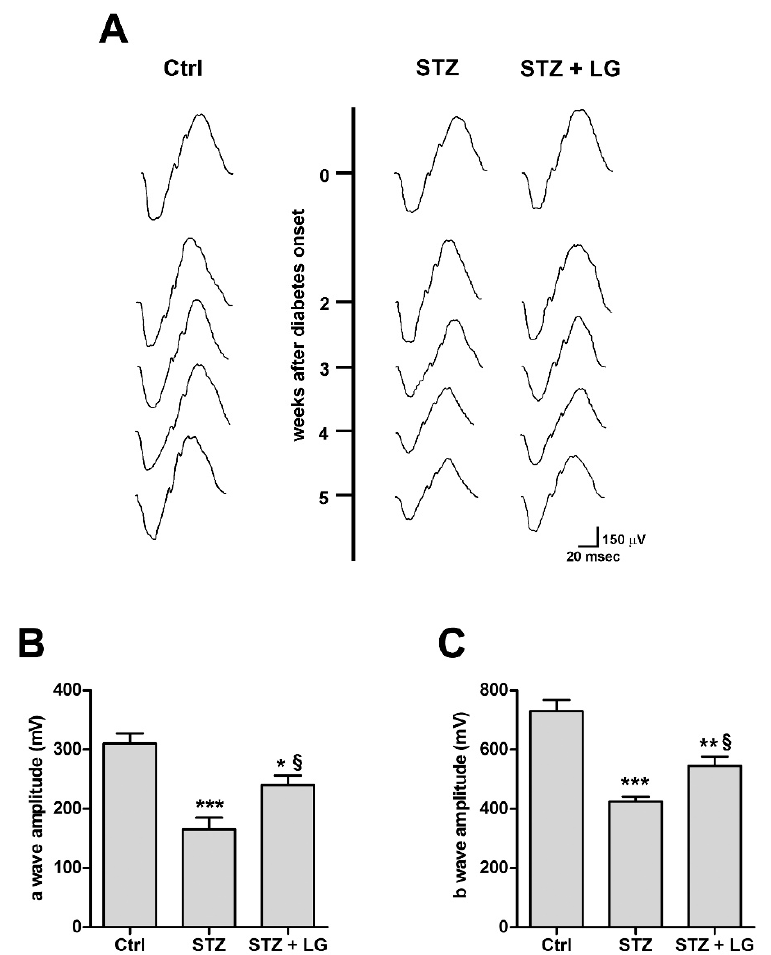
Figure 5. LG partially restored electroretinogram (ERG) responses. ( A ) Representative